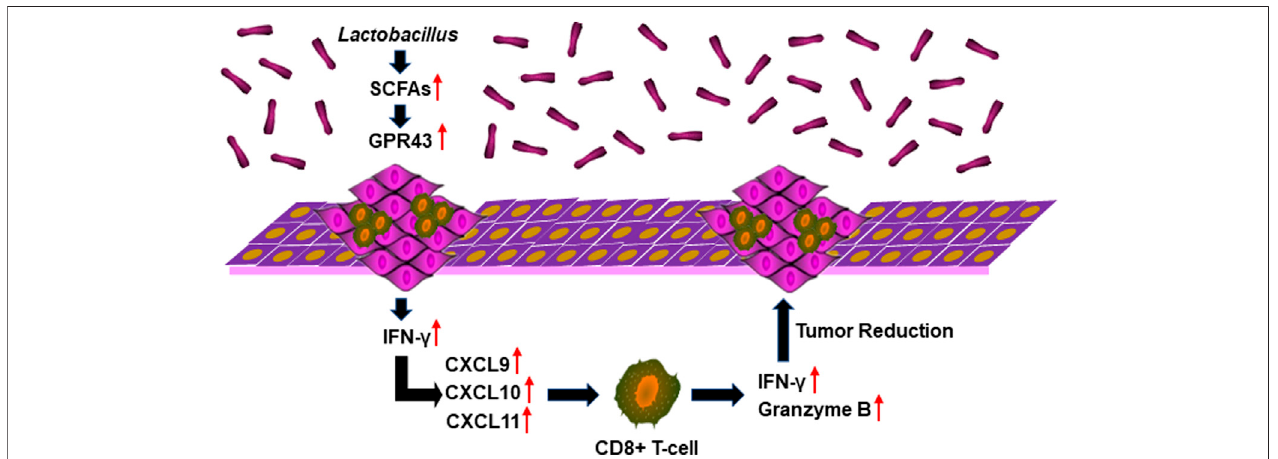
FIGURE8| Lactobacillus metabolitessuppressthedevelopmentofOPCthroughanti-tumorimmunity. Lactobacillus metabolitesincreasedtheexpressionofIFN- γ and IFN- γ -inducible chemokines CXCL9, CXCL10 and CXCL11 in oropharyngeal tissues byactivatingGPR43, thereby promoting the in fi ltration of CD8 + T cells and the secretion of IFN- γ and Granzyme B and inhibiting the OPC